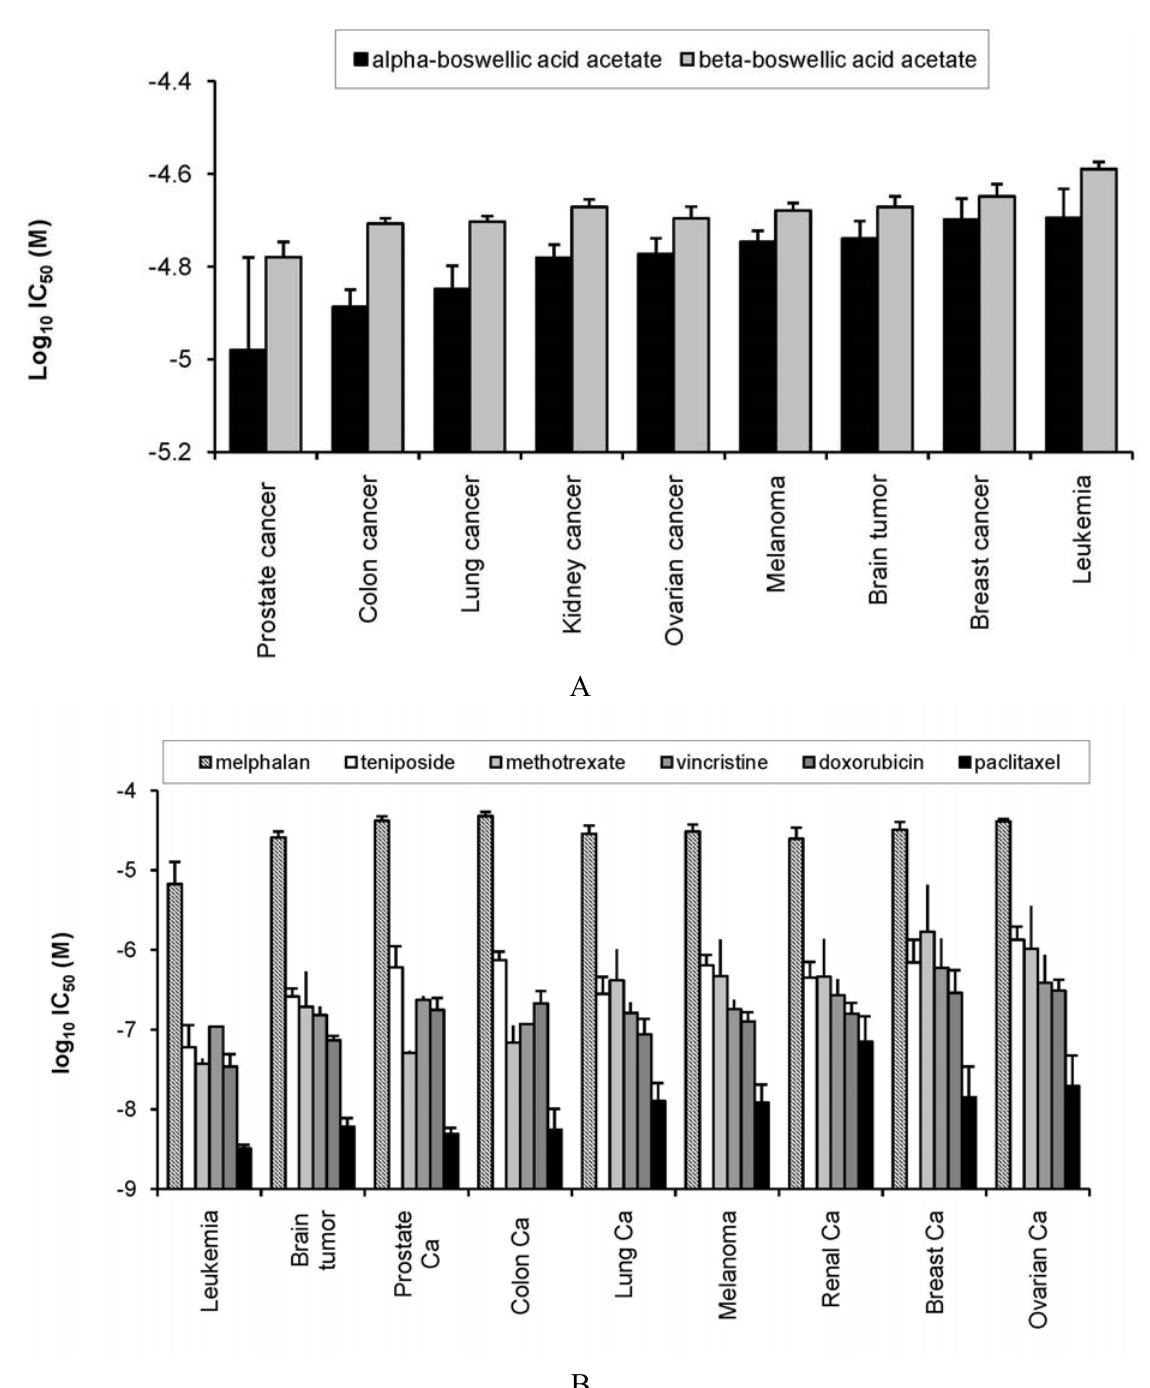
Figure 2. Cytotoxic activity of boswellic acids (A) and established anticancer drugs (B) towards cell lines of different tumor types. 50% inhibition concentration (log (M) for α - and β -boswellic acids or standard drugs were determined by the sulforhodamine assay and grouped according to tumor types (mean ±